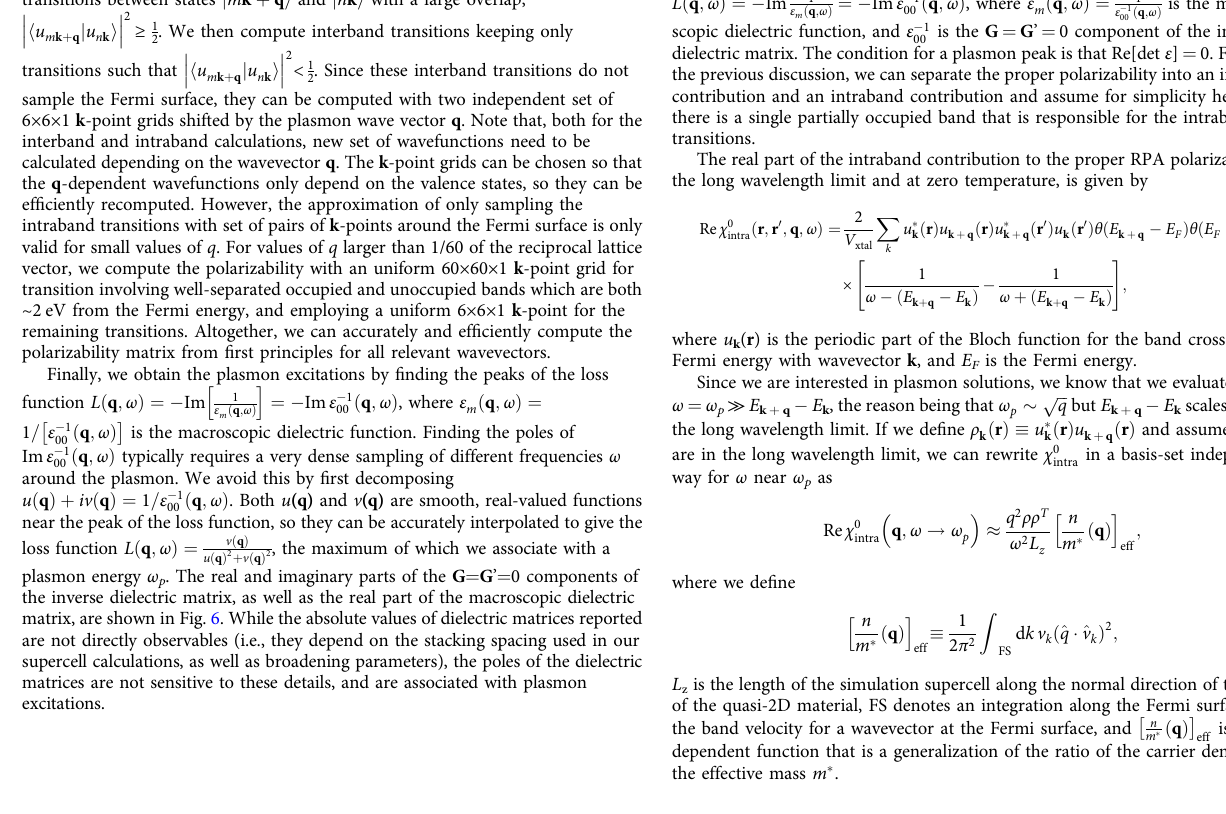
special anchor points { k a } along the different pieces of the Fermi surface, in a way that: (i) v ( k a )· q < 0, where v ( k ) is the band velocity at k (this will later ensure that the product of the occupation factors f m k + q (1 − f n k ) is nonzero); and (ii) their spacing along the direction perpendicular to q is fi xed as 1/ N a . Note that N a is not the total number of anchor points, but the maximum number of anchor points that a closed and concave Fermi surface could have. We choose N a to be large enough to fi nely sample transitions along the Fermi energy, around N a ~ 60; however, note that N a does not depend on the magnitude of q , but on the size of the Fermi surface. We then distribute the actual k points that will go into the calculation of (cid:8) (cid:9) q χ 0 k ¼ k a , so that each pair of k i i ± intra in pairs around the anchor points, i.e., as 2 i points will sample a transition along the various pieces of the Fermi surface. We then perform the calculation of χ 0 intra with these special set of k points and by including only intraband transitions. This is enforced by keeping only